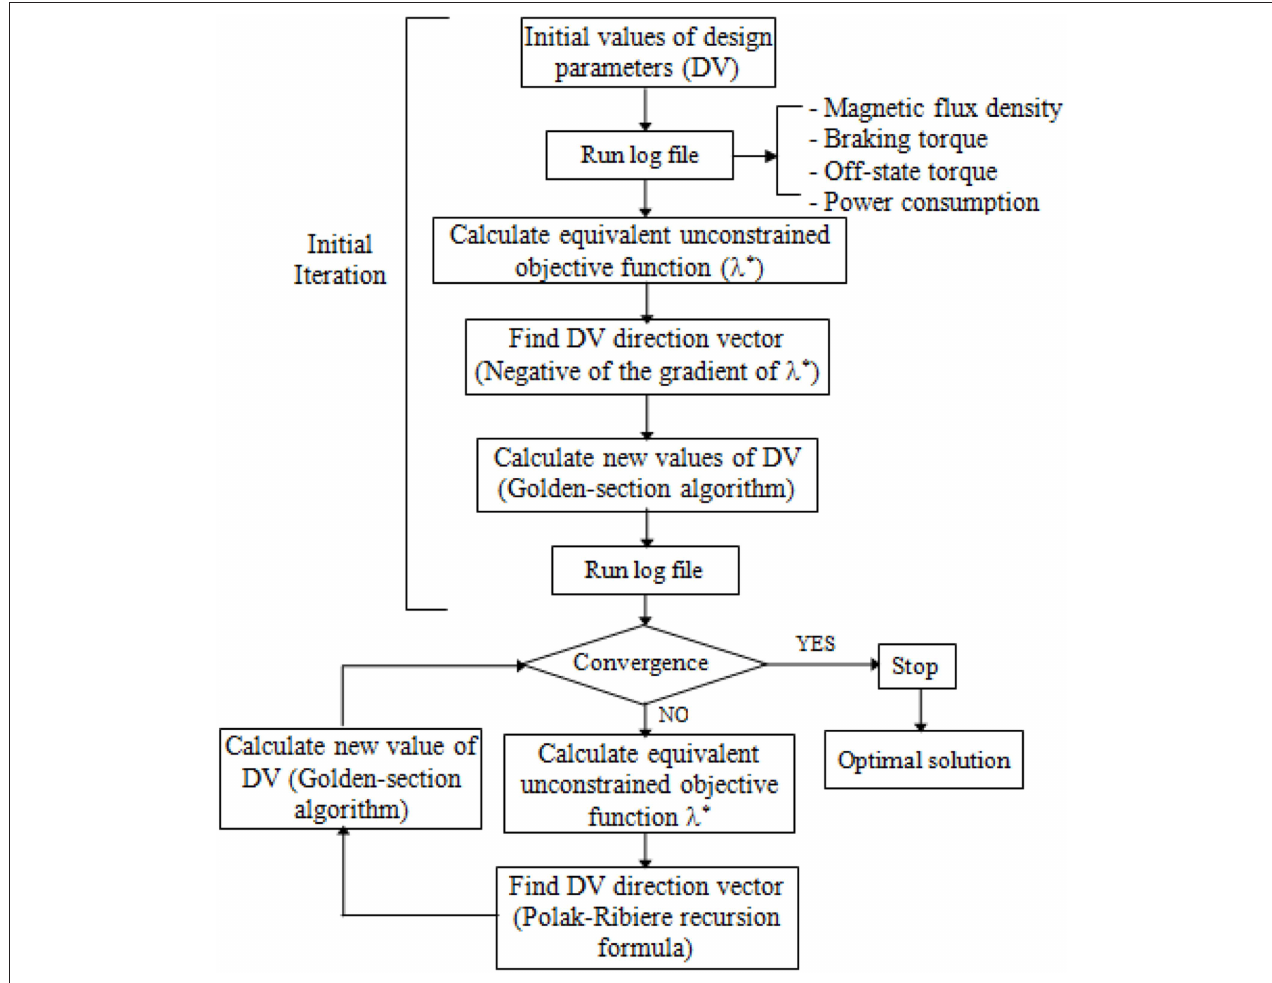
FIGURE 3 | Flow chart for optimal design using